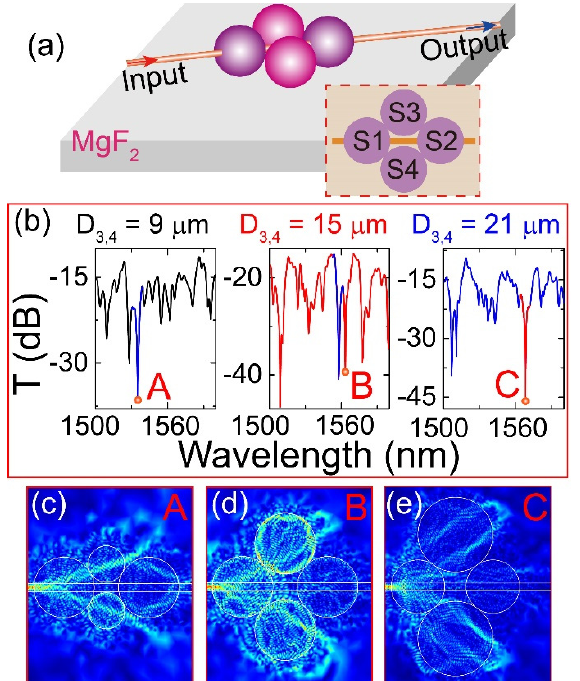
Figure 7. ( a ) Schematic of silica taper-assisted 4-spheres-loop sensor. Inset shows the cross section of 4-spheres-loop (S1, S2, S3, and S4). ( b ) The transmission (T) spectra of 4-spheres-loop sensor with D 1 = D 2 = 15 µm and gap = 6 µm under different diameters of S3 and S4 ( D 3 = D 4 = D 3,4 ). ( c – e ) Electric field distributions at points A, B and C in Figure 7b.